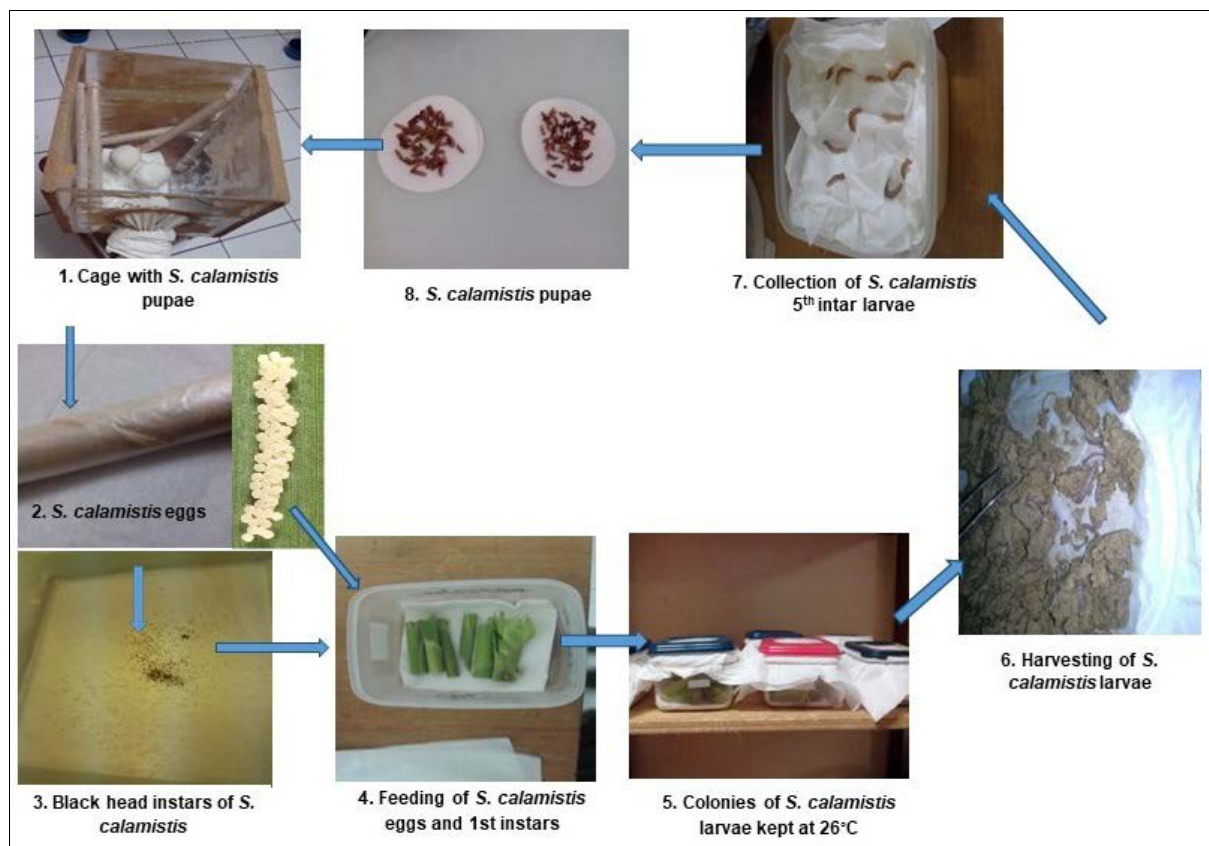
Figure 1: Steps in the artificial rearing of Sesamia